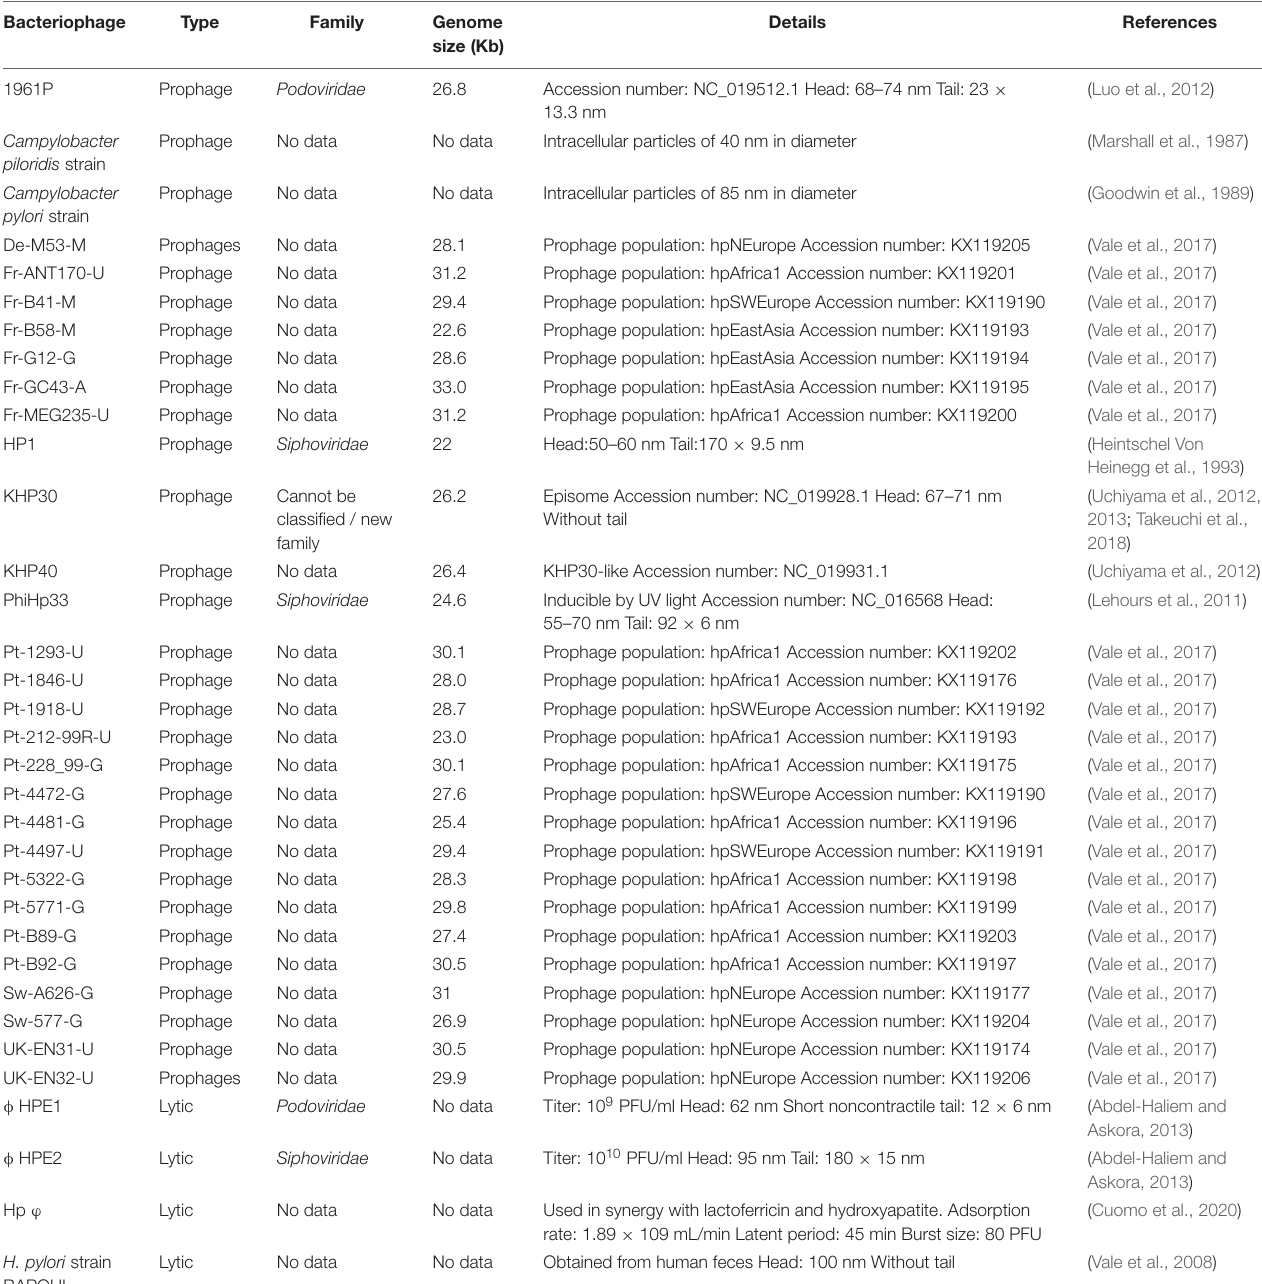
TABLE 1 | Main bacteriophages of H.